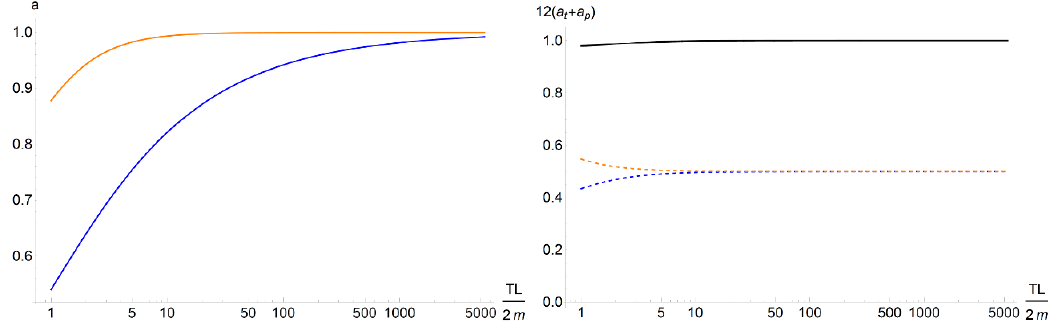
Figure 7 . Left: the intercept in D = 4 (lower, blue line) and in D = 26 (orange). For D = 4 the PS term is dominant. Right: here we plot the contributions from the (cid:13)uctuations separately, where the dashed lines are a t (blue) and a p (orange), and the solid line a p + a t . We normalize this by 1 , which is the value of a t + a p at TL=m ! 1 12